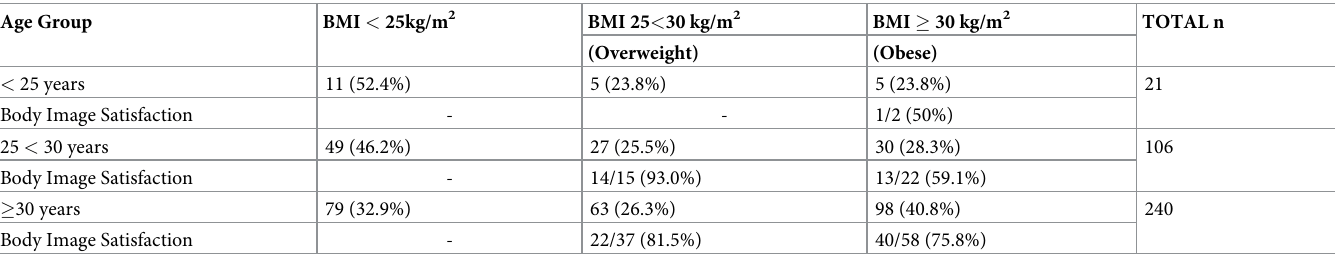
Table 3. Obesity and satisfaction with body image by age